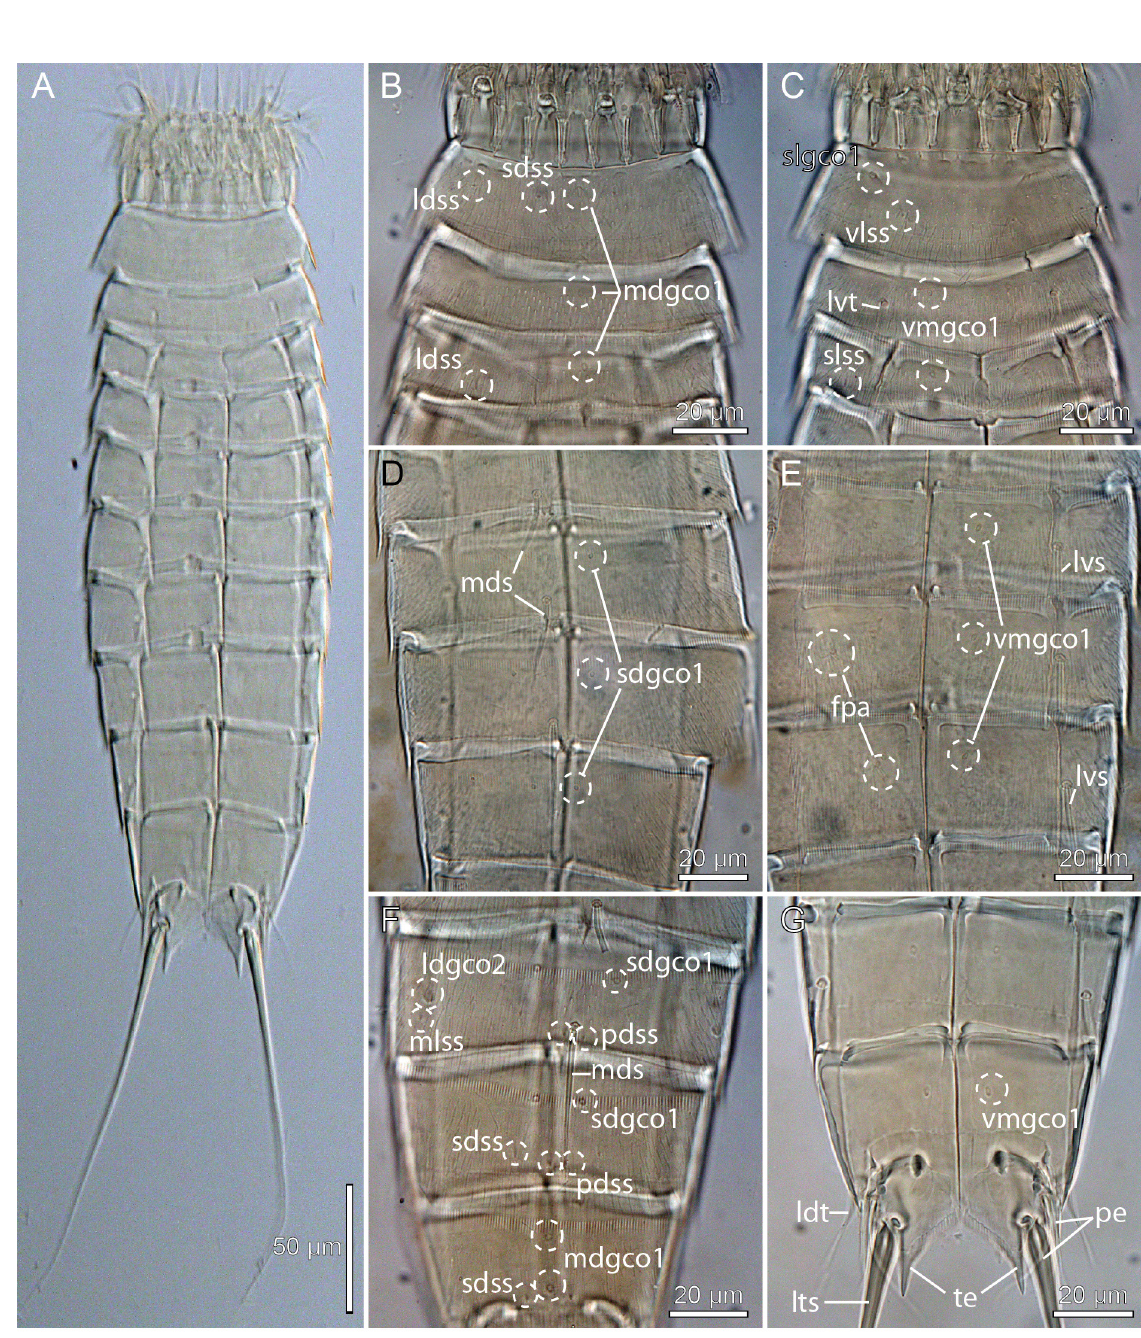
Fig. 25. Light micrographs showing overviews and details of Echinoderes sp. from Havelock Island, Andaman Islands. A–C, F–G . ♂ (USNM-55398). D–E . ♀ (USNM-55393). A . Ventral overview. B . Segments 1 to 3, dorsal view. C . Segments 1 to 3, ventral view. D . Segments 6 to 9, dorsal view. E . Segments 6 to 8, ventral view, showing female sexual dimorphism. F . Segments 8 to 10, dorsal view. G . Segments 9 to 11, ventral view, showing male sexual